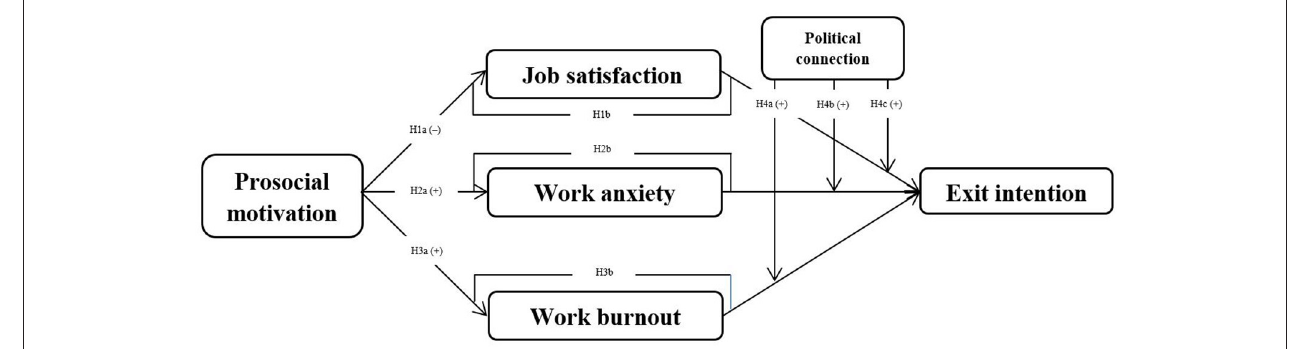
FIGURE 1 | Theoretical